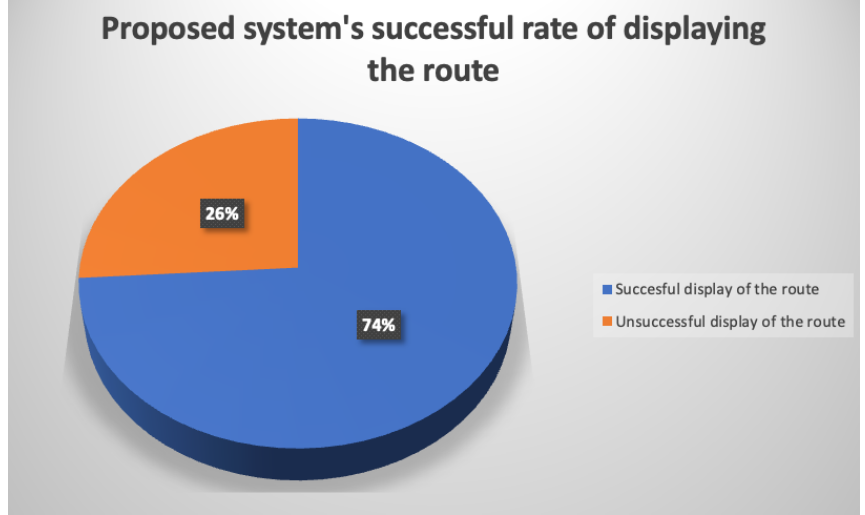
Figure 2. Successful rate in regard to the display of the route from the proposed